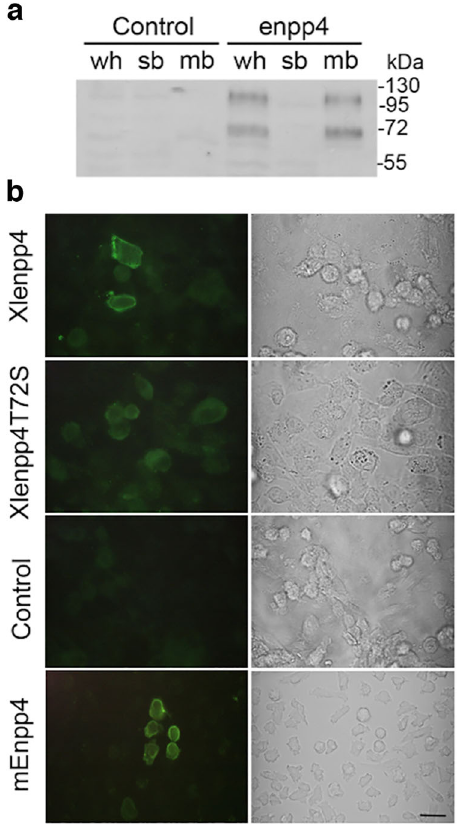
Fig. 5 Enpp4 is a transmembrane ectonucleotidase. a CHO cells were transfected with Xl enpp4 -pcDNA3.1 or empty vector (control) and the cellular distribution of Enpp4 determined by western blotting using anti- XlEnpp4 antibody and proteins extracts from membrane (mb), soluble (sb) or whole cells (wh) fractions. b Representative images of the cellular distribution of Enpp4 determined by immuno fl uorescence using anti- XlEnpp4 or anti-mEnpp4 antibodies from CHO cells transfected with Xl enpp4 -pcDNA3.1, Xl enpp4T72S -pcDNA3.1, mEnpp4- pcDNA3.1 or empty pcDNA3.1 vector (control). Corresponding bright fi eld images are also presented. Scale bar represents 20 µ